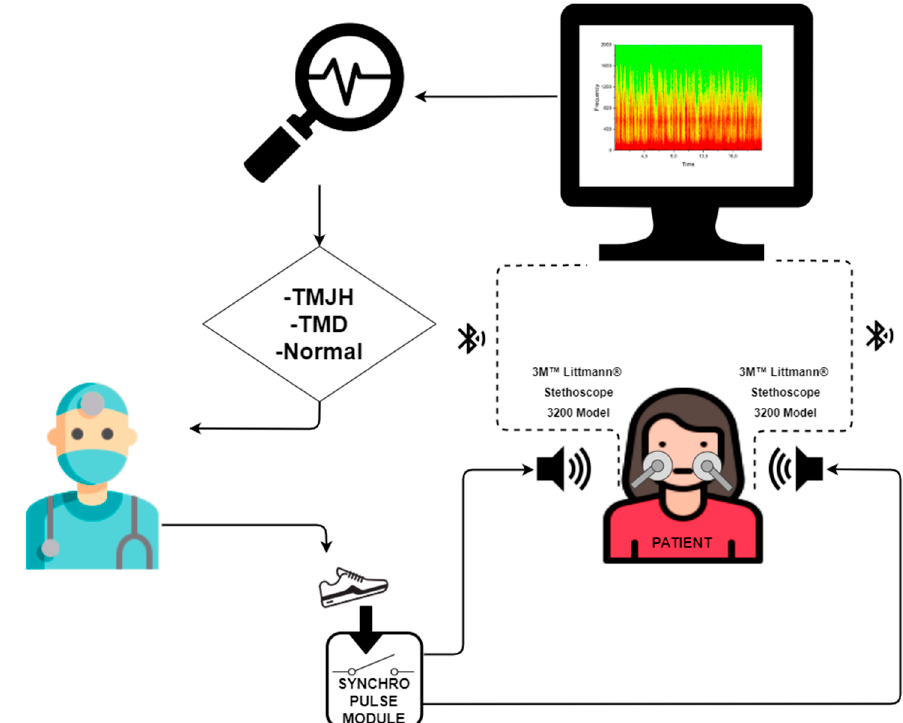
Figure 2. Visualisation of the entire examination procedure.